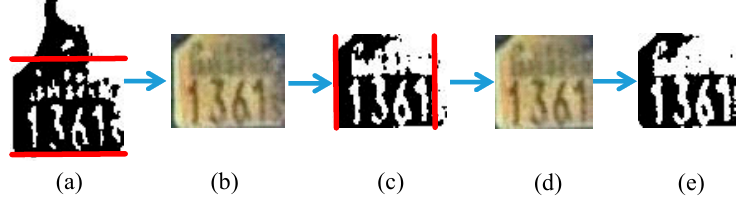
Figure 10. Removal of unnecessary borders: ( a ) Preprocessed image with two horizontal crop lines, ( b ) horizontally cropped original image, ( c ) horizontally cropped preprocessed image with two vertical crop lines, ( d ) unnecessary border removed from original image, and ( e ) preprocessed image with unnecessary borders removed.